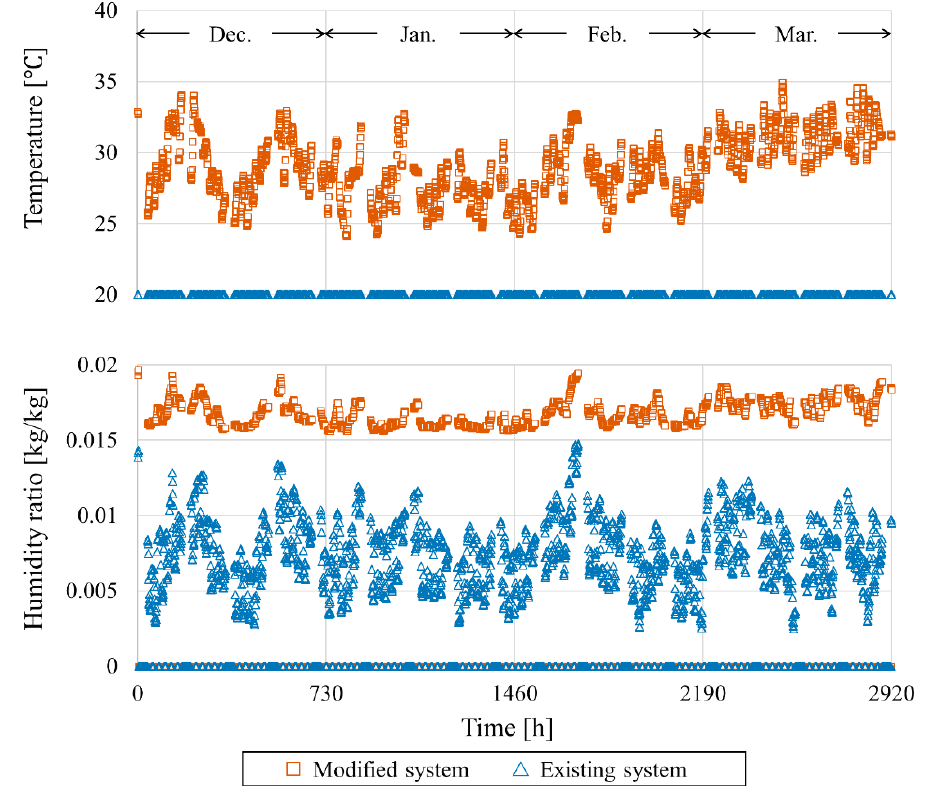
Figure 13. Temperature and humidity ratio of the SA in each system.